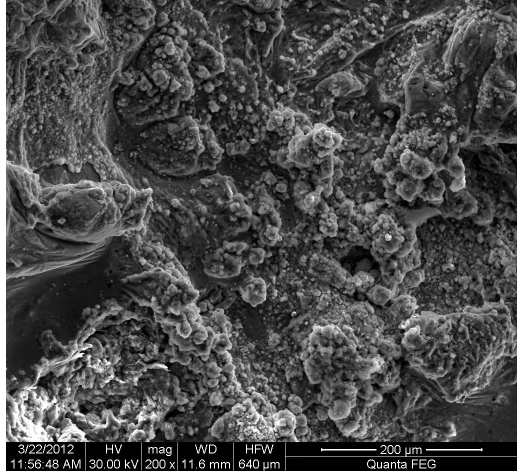
Figure 9 Crater formation on the electrical discharge machined